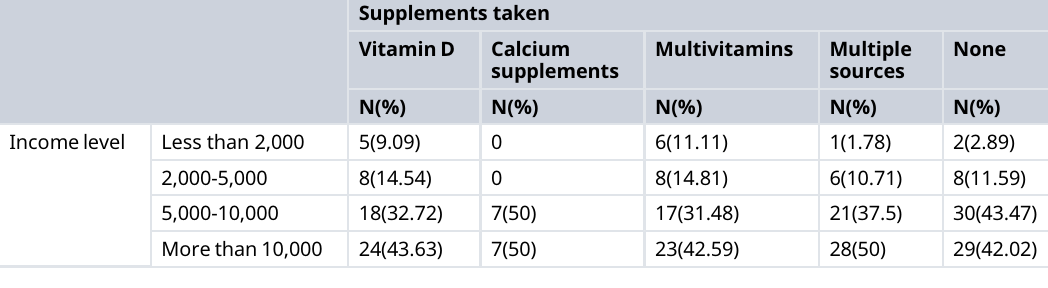
Table 4. Participant ’ s income level and supplementation practices.